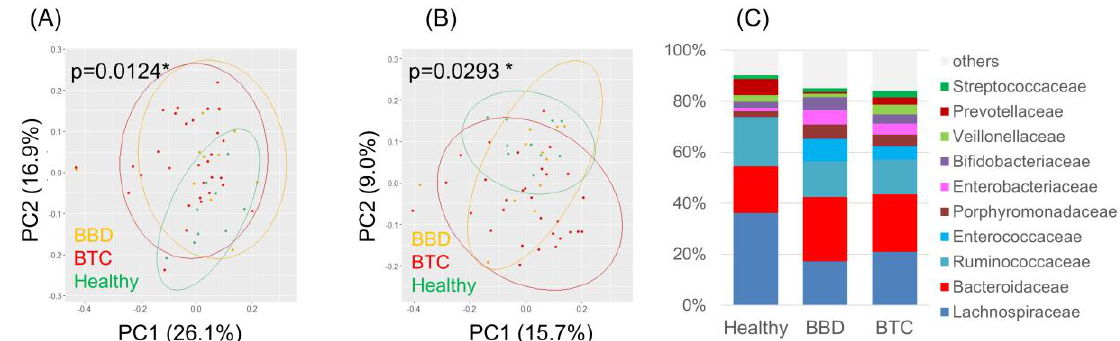
Figure 2. Overview of the fecal microbiota in patients with BTC, patients with BBD and healthy subjects. ( A ) Weighted and ( B ) unweighted UniFrac PCoA of the fecal microbiota; ( C ) Composition of the fecal microbiota at the family level. * p < 0.05. LEfSe indicated a higher abundance of Gammaproteobacteria , including